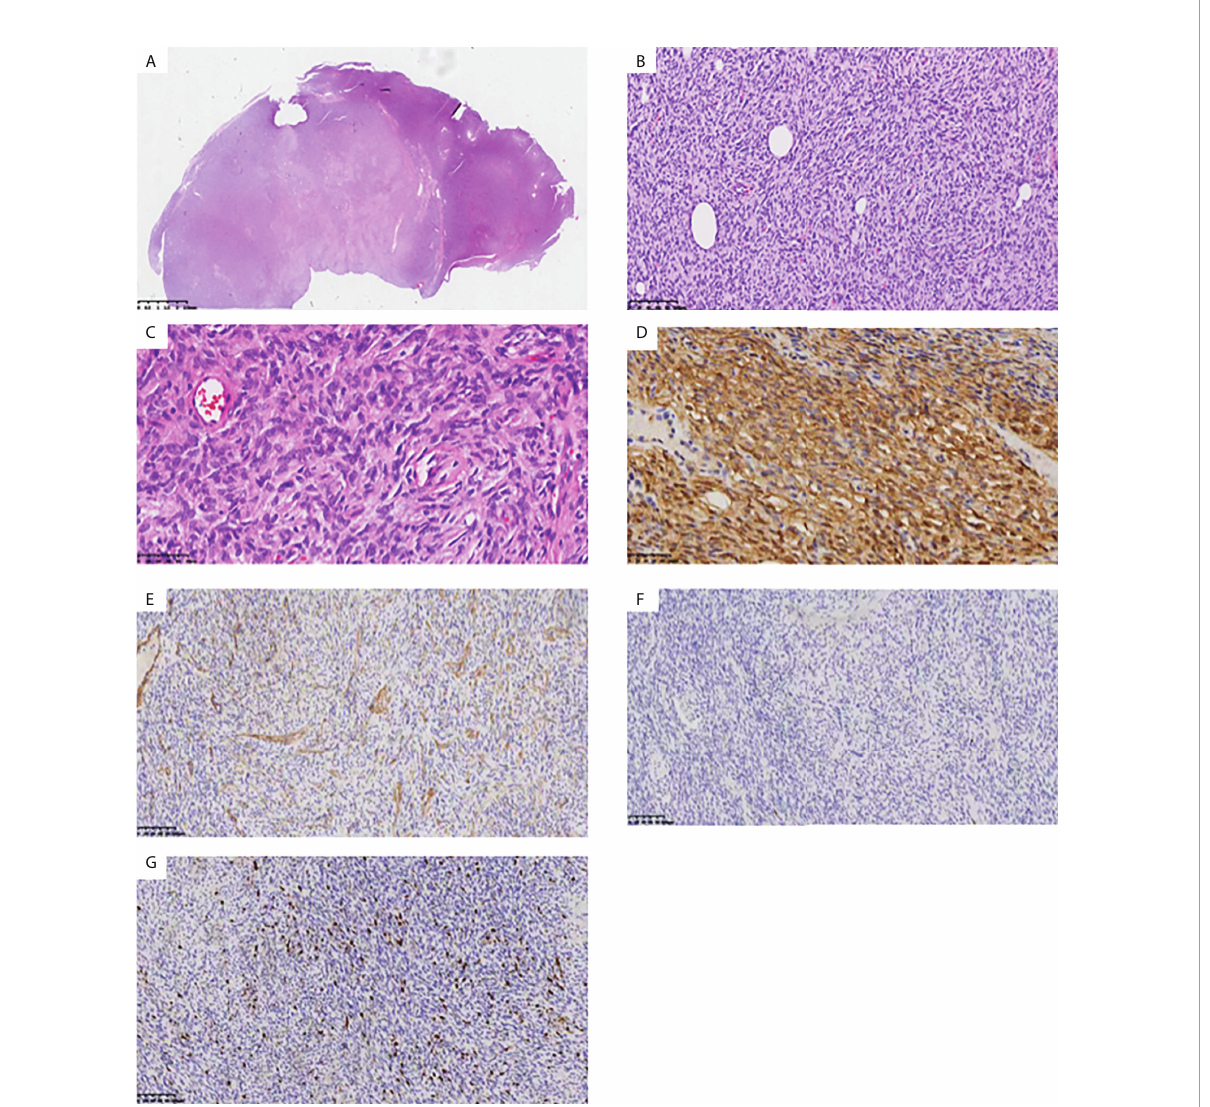
FIGURE 1 Histopathologic stains from the inner mass of the right back. HE staining results suggested spindle cell tumor. Low-power (A) , medium-power (B) , and high-power (C) view demonstrating a partially encapsulated nodular mass without dermal connection. Immunohistochemistry results suggested dermato fi brosarcoma protuberans: CD34 (+) (D) , SMA (-) (E) , S100 (-) (F) , Ki67+ 5-10% (G)